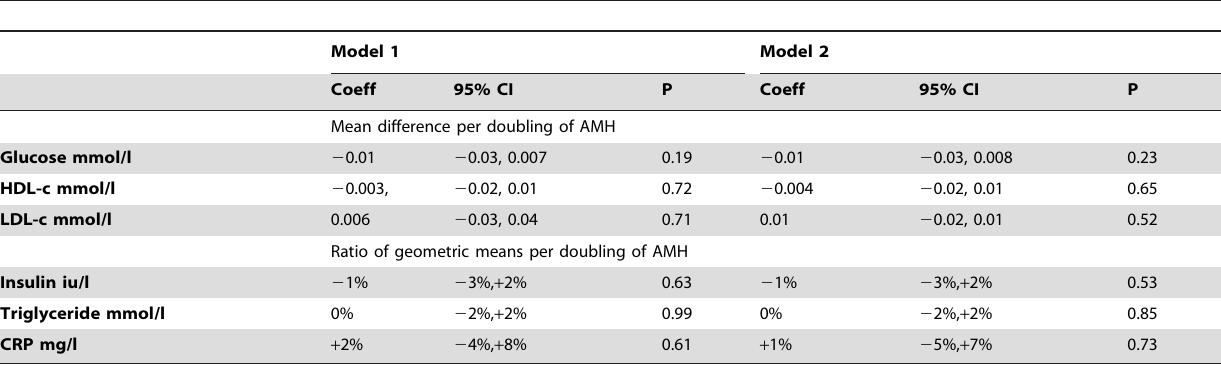
Table 4. Multivariable associations of AMH with cardiometabolic risk after excluding 170 (13%) participants taking the hormonal contraceptive pill